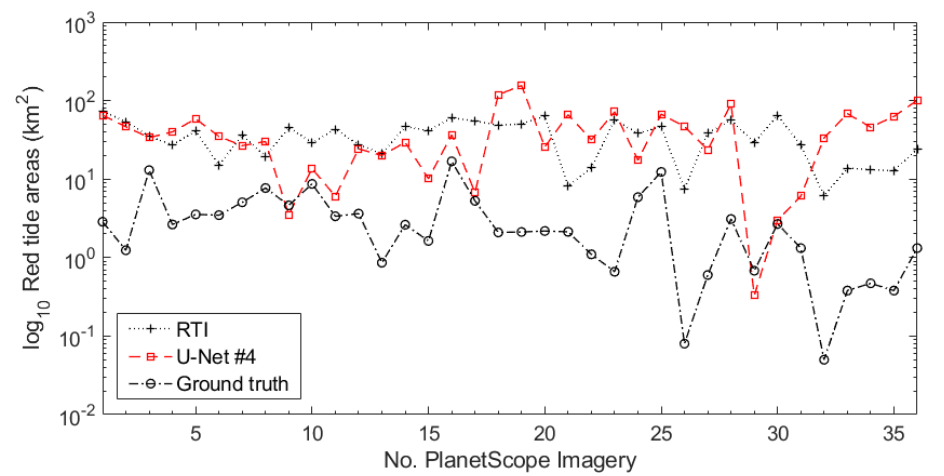
Figure 9. Red tide areas extracted from RTI, U-Net #4, and ground-truth maps of 36 PlanetScope images.